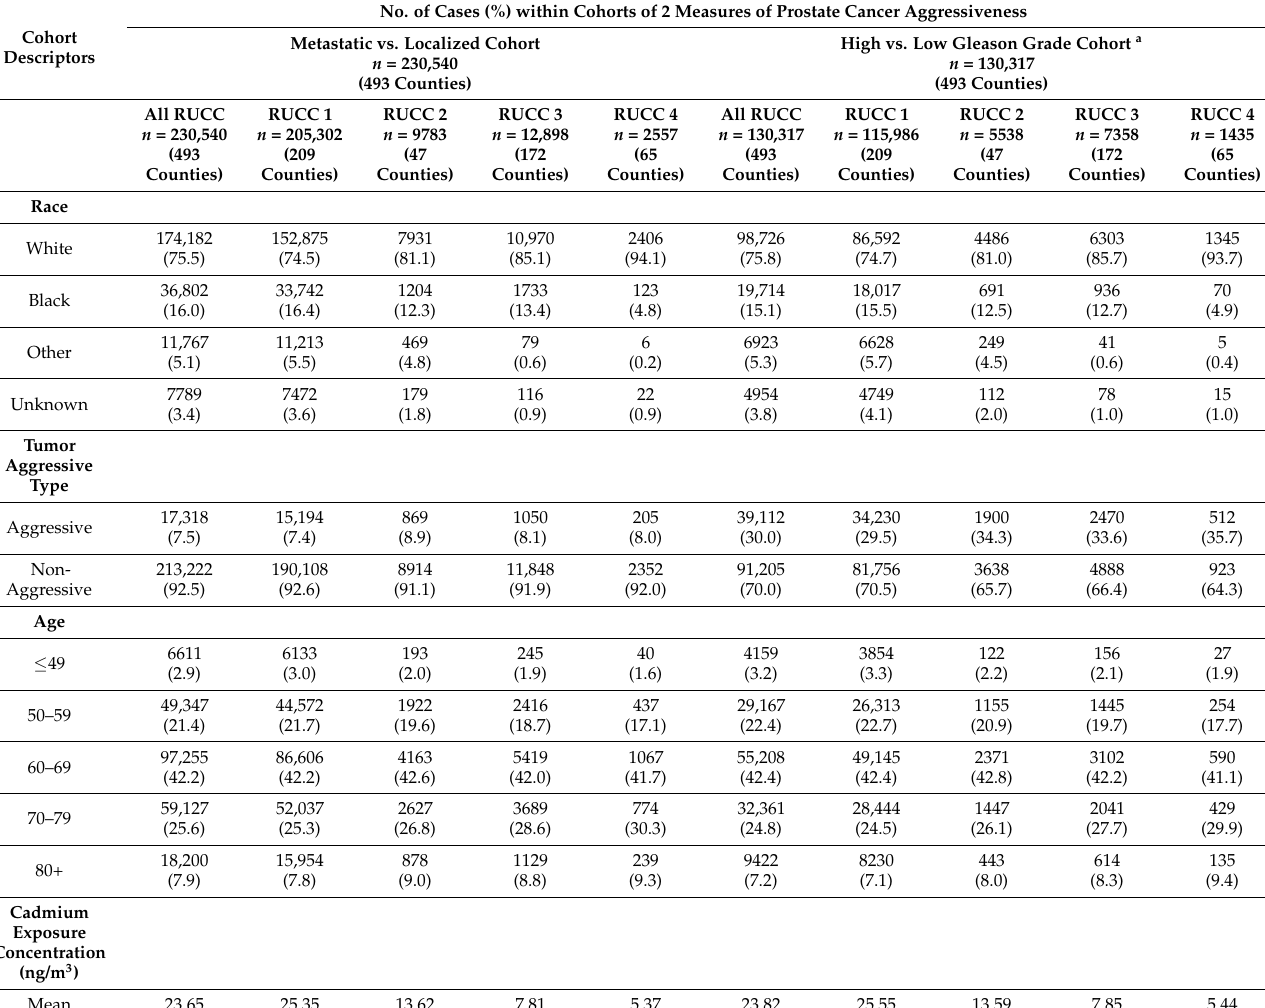
Table 1. Cohort descriptives of prostate cancer cases obtained from the 2010–2014 Surveillance, Epidemiology, and End Results